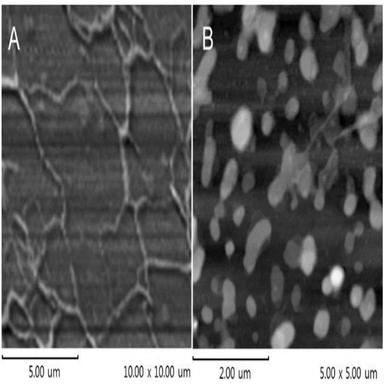
AFM imaging of two G. lucidum polysaccharides. (A) GLP-1; (B) GLP-2.